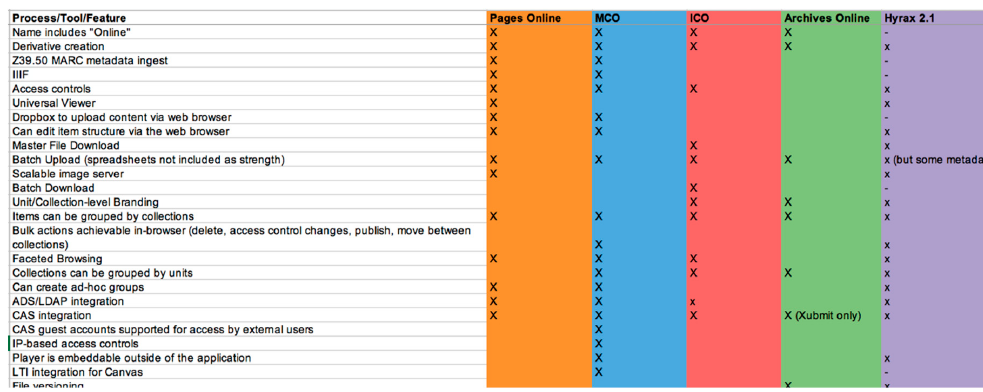
Figure 7. Screen shot of the Process/Tool/Feature comparison across current digital collection services and Hyrax software.